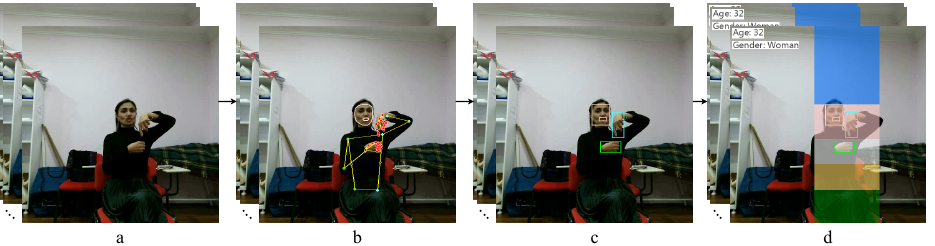
Figure 7. Pipeline for determining graphic regions of interest and gesture zones: ( a ) source frames of the video stream; ( b ) detected landmarks of the face (including lips), hands, and body; ( c ) graphic regions of the face, lips, and hands; ( d ) gesture